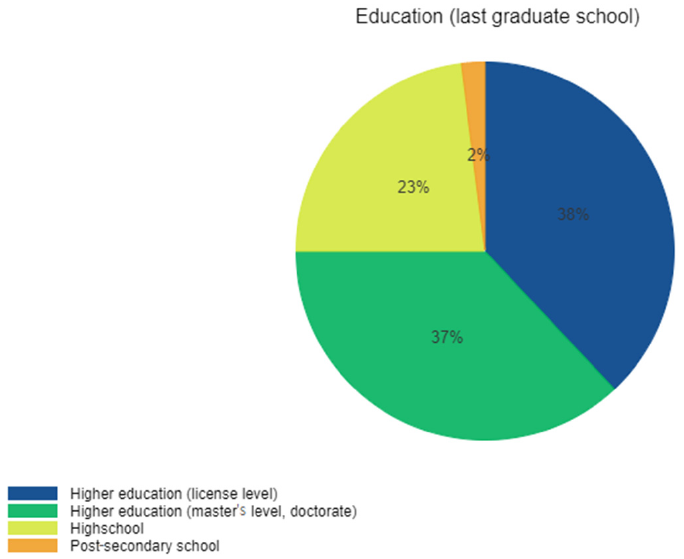
Figure 3. The educational level of the responders.